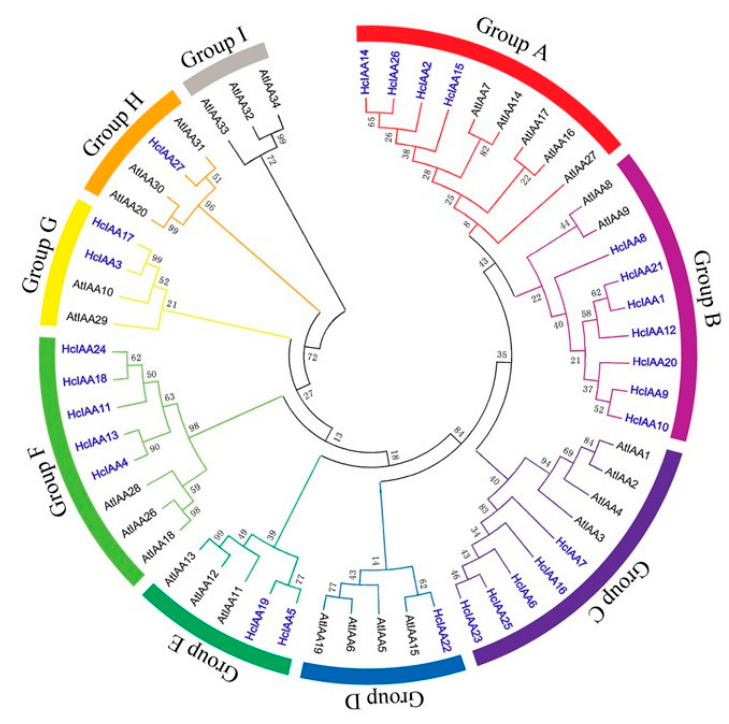
Figure 2. Phylogenetic analysis of H. coronarium and Arabidopsis Aux / IAA proteins. Full-length protein sequences were aligned by using the Clustal X 2.1 program. The phylogenetic tree was constructed by using MEGA 6 software and the neighbor-joining method with predicted Aux / IAA proteins. Bootstrap values are indicated at each node. Each Aux / IAA group (A–I) is indicated by a specific color. HcIAAs are noted in blue and bold.